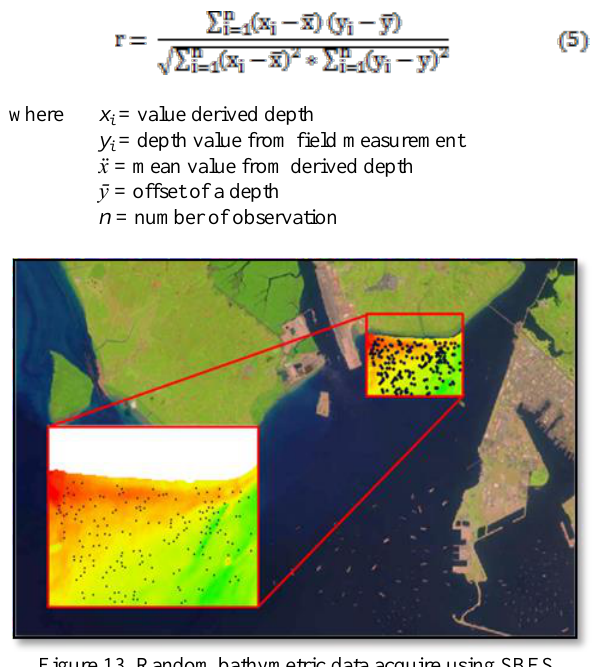
Figure 13. Random bathymetric data acquire using SBES. The overall results for both derivation models are described in Table 1 below. The statistical analysis shows that Dierssen et al.’s model obtains RMSE of 0.878 metres while Staumpf et al’s model delivers RMSE of 0.885 metres. While, the absolute differences between known depths and estimated depths at those points vary from 0.005 metres to 3.245 metres with the MAE equals to 0.629 metres for Dierssen et al.’s model, whilst the MAE obtains by Stumpf et al.’s model is 0.631 metres. In the meantime, to validate the models, the correlation coefficient (r) is computed. Both models show a similar correlation coefficient of 0.76. Generally, the outcomes of the statistical analysis indicate that the imagery-derived bathymetry models provide Figure 12. Imagery-derived bathymetric model (study area) satisfied results in this highly turbid water region. from Dierssen et al’s band ratio approach.